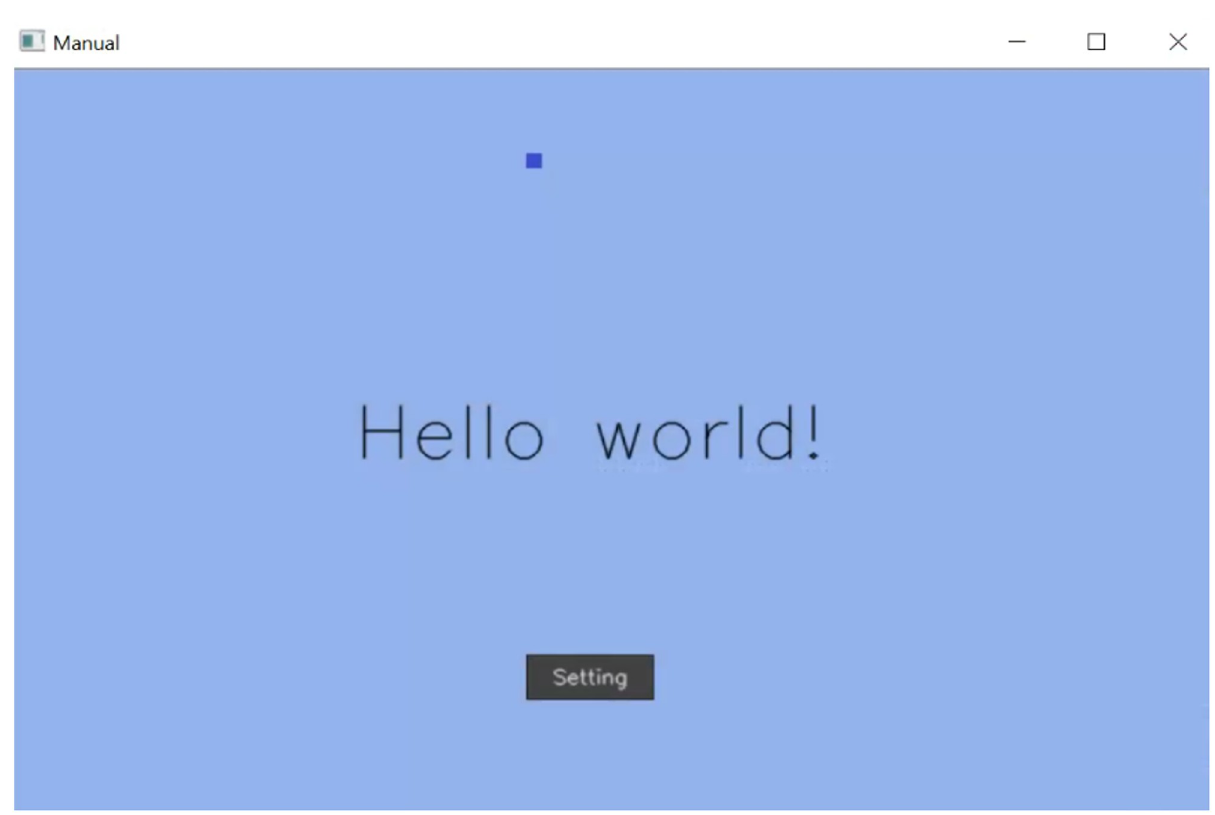
Fig 7. Manual AUI main window.